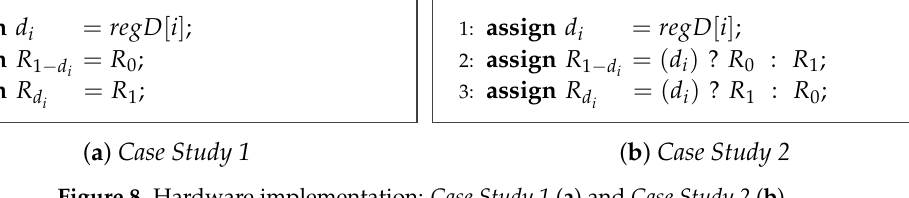
Figure 6. Hardware implementation: one of the sub-traces (top) and SOST value between two sub-groups (bottom)